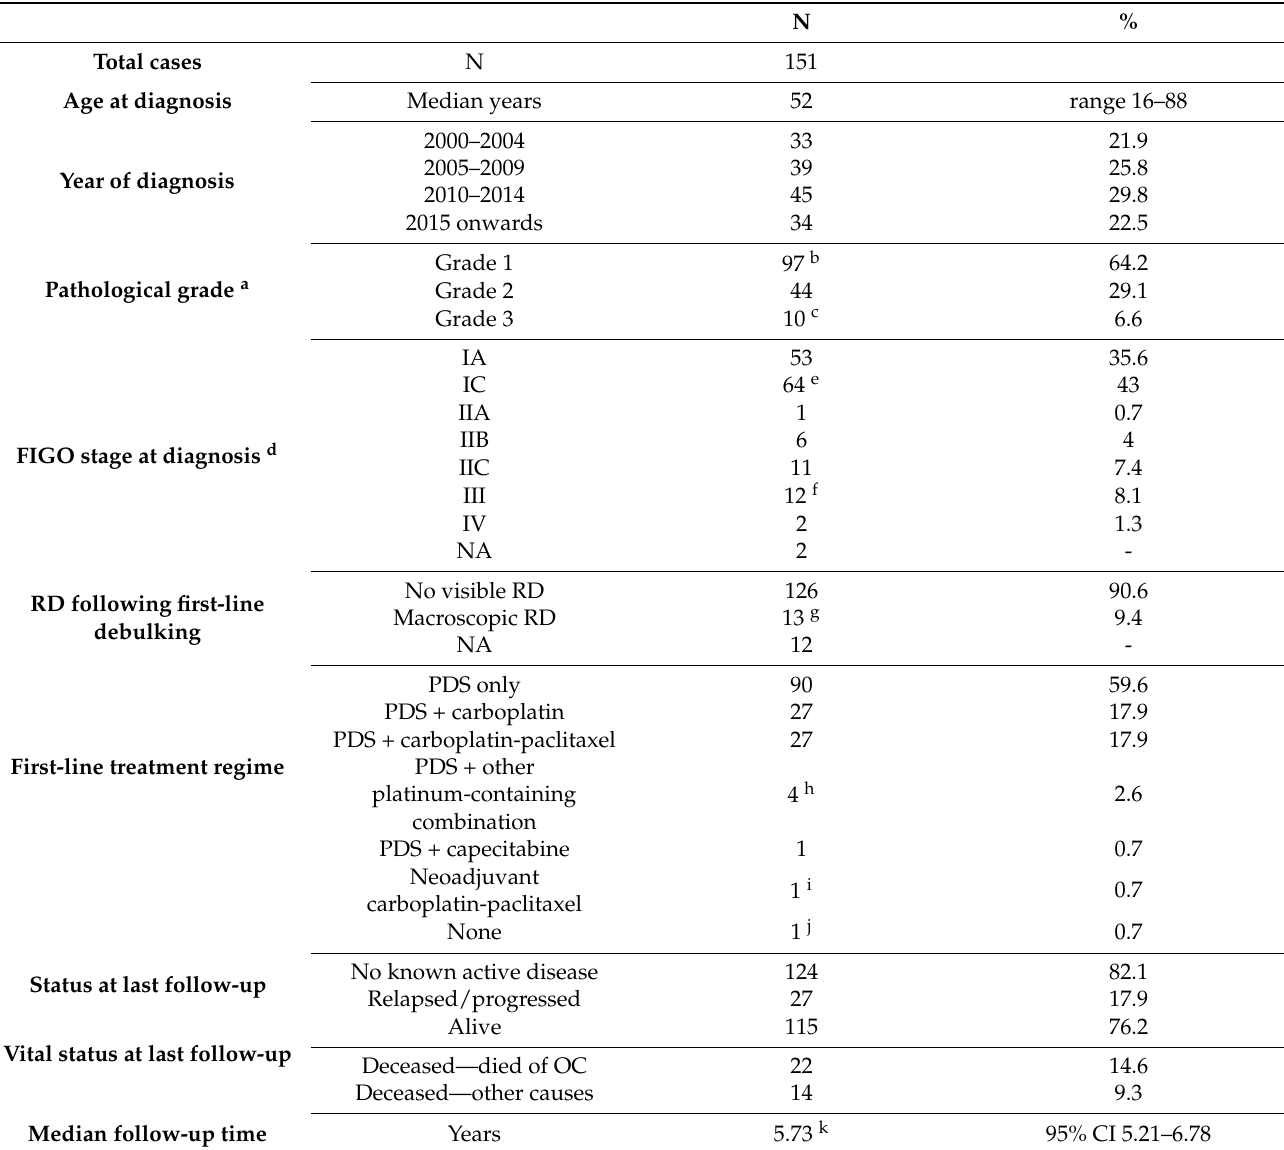
Table 1. Characteristics of mucinous ovarian carcinoma study